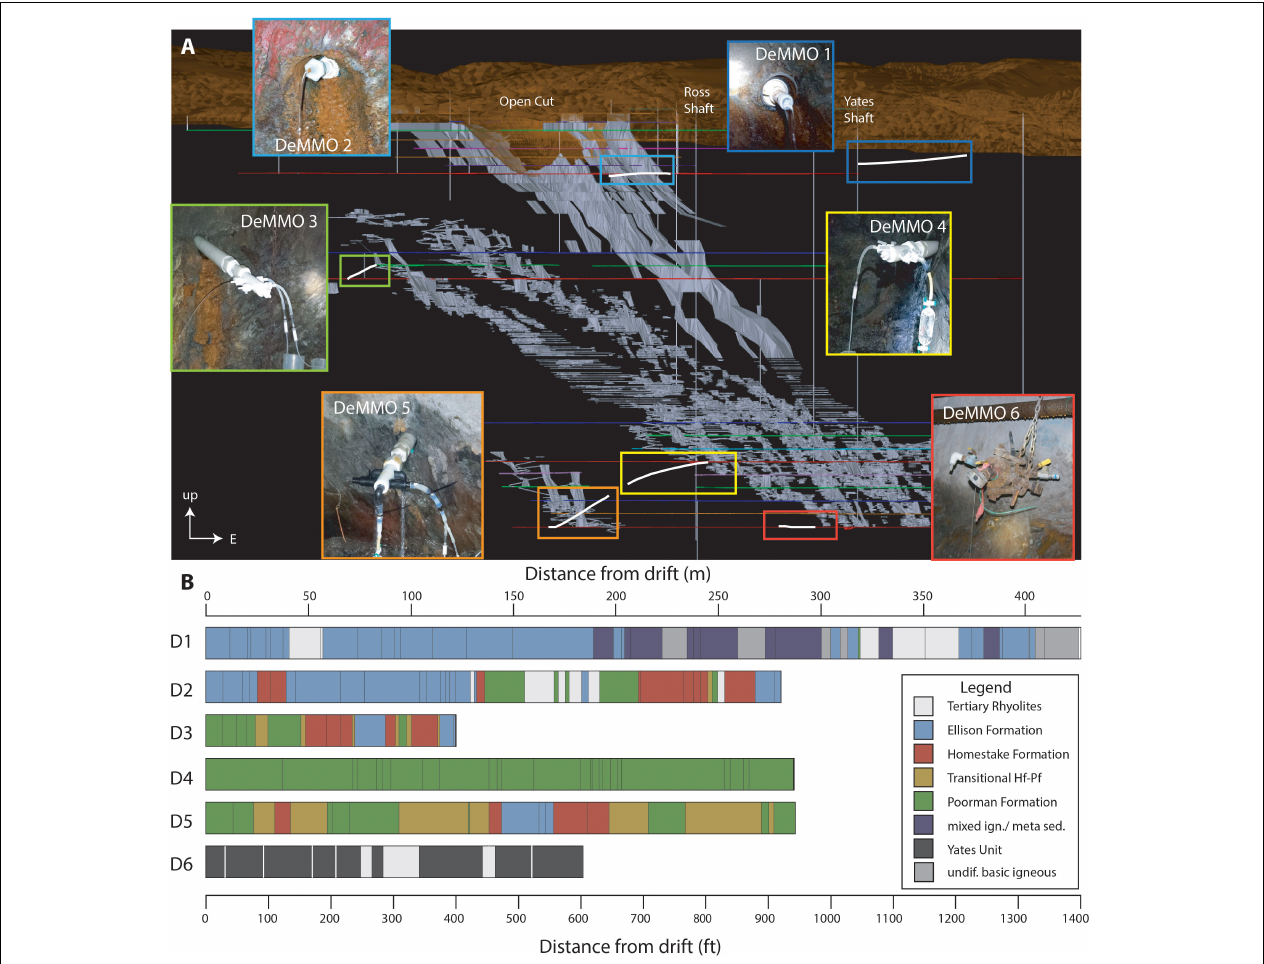
FIGURE 2 | Overview of SURF superstructure and borehole placement, trajectories, and intersecting lithologies. (A) A 3D georeferenced map of SURF and picture of each site. View is looking from south to north (map made by Kathy Hart using Vulcan Software printed with permission from SURF). Mined stopes shown in gray, borehole trajectories in white, mining levels in colored horizontal lines, and shafts in vertical gray lines. (B) Lithological units in boreholes from origin (0) to terminus compiled from each borehole log report.